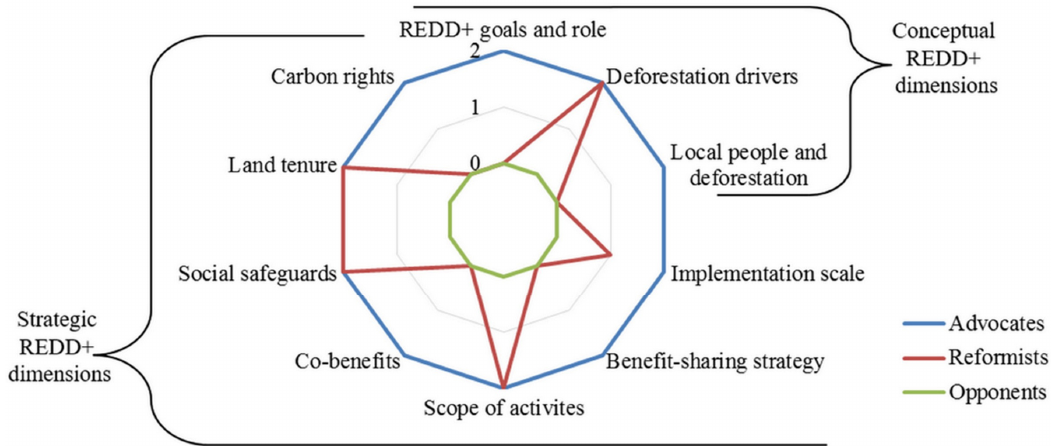
Figure 4. Degree of structuration and institutionalisation of the central storylines on ten key REDD+ dimensions. 0, no storyline included in the REDD+ documents; 1, storyline implicitly included; 2, storyline explicitly included. Source: own elaboration. Table 4. Quotes related to the ten key REDD+ issues extracted from the analysed documents and paraphrased for length. Source: own elaboration from the sources indicated in the Table. FCPF, Forest Carbon Partnership Facility; PES, payment for ecosystem services.